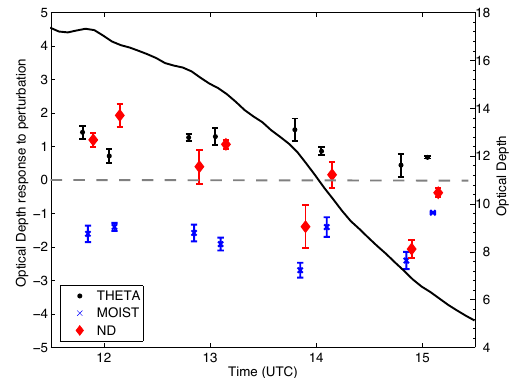
Fig. 11. Response of optical depth ( τ ) to perturbations in meteoro- logical context and aerosol state, computed from the experimental simulations (left y-axis). Responses of τ are shown as described in Fig. 11. For reference the black line shows the time series of base case τ (right y-axis) and the grey dashed line indicates a zero re- sponse in τ